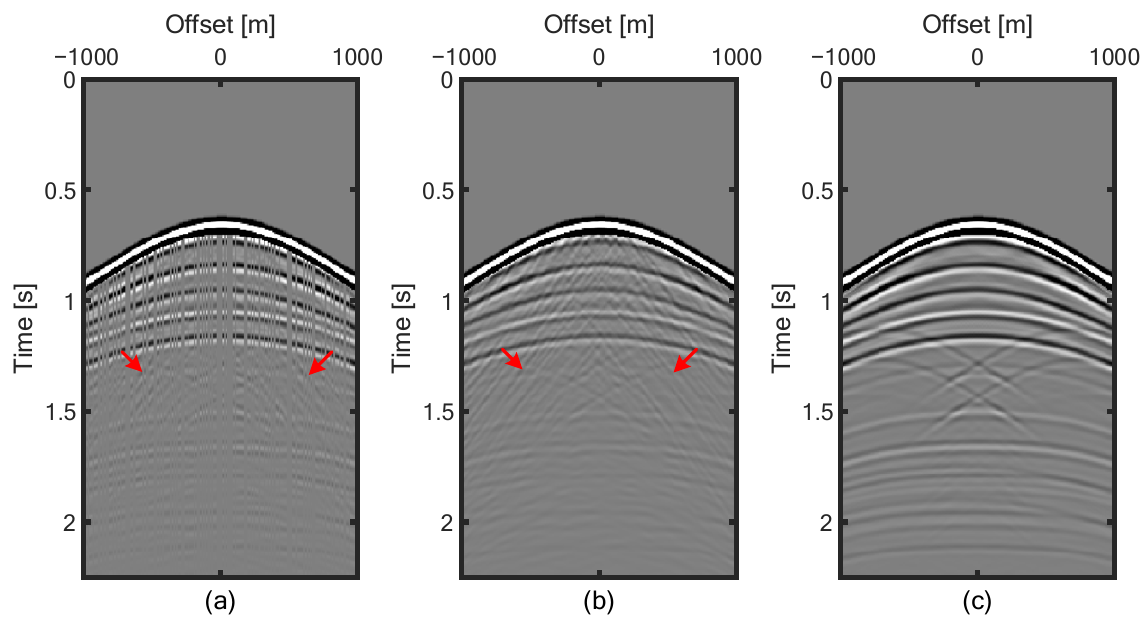
Figure 4. The Green’s functions obtained using the standard Marchenko method integrated under the receiver dimension. They are sampled ( a ) under the source dimension; ( b ) under the receiver dimension; ( c ) regularly. Red arrows point out partial artifacts.